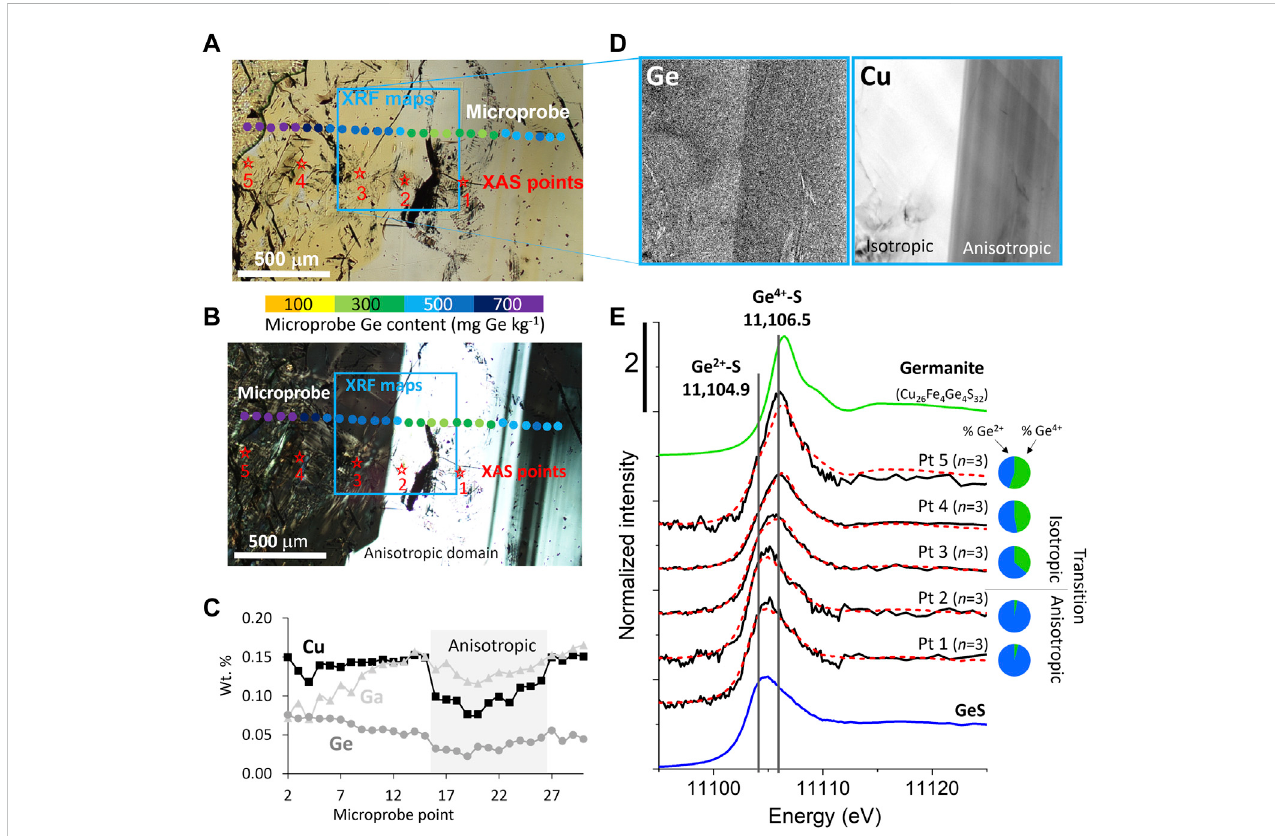
FIGURE 3 GecontentandspeciationgradientinCentralTennesseesphalerite(sampleZnS_5). (A) Plane-polarizedtransmittedlightimageshowingtransparentZnS strip vertically bisecting image. (B) Cross-polarized transmitted light image with anisotropic ZnS strip vertically bisecting image. In Figures 3A,B, red stars indicate μ -XANES locations, and colored dots indicate microprobe locations, with dot color indicating Ge content. (C) Electron microprobe-determined content ofGe,CuandGafor thesametransectshowninFigures 3A,B. (D) μ -XRFmapsdemonstrateGeand Cuspatialdistibutionforareade fi nedbythe blue boxes in Figures3A,B (maps individually scaled with lowest intensity shown inblack and highestintensity shown in white). (E) Germanium XANES spectra for transect shown in red stars in Figures 3A,B. Linear combination fi ts are shown in red dashed lines, with results shown in pie charts. These fi ts indicate progressiveincreaseinGe 4+ abundancefrom point1 to point5 withthelargestdifferenceintheobservedspeciationmixturebetweentheanisotropicdomain (mostly Ge 2+ ; points 1 to 2 ) and isotropic domains (mixed Ge oxidation states; points 3 to 5